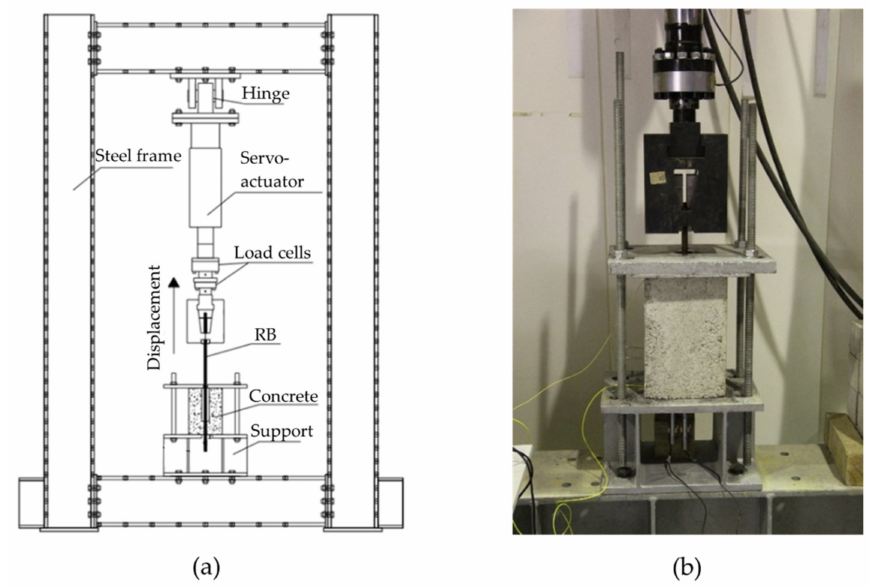
Figure 5. Pull-out testing setup: ( a ) Illustrative description. ( b )